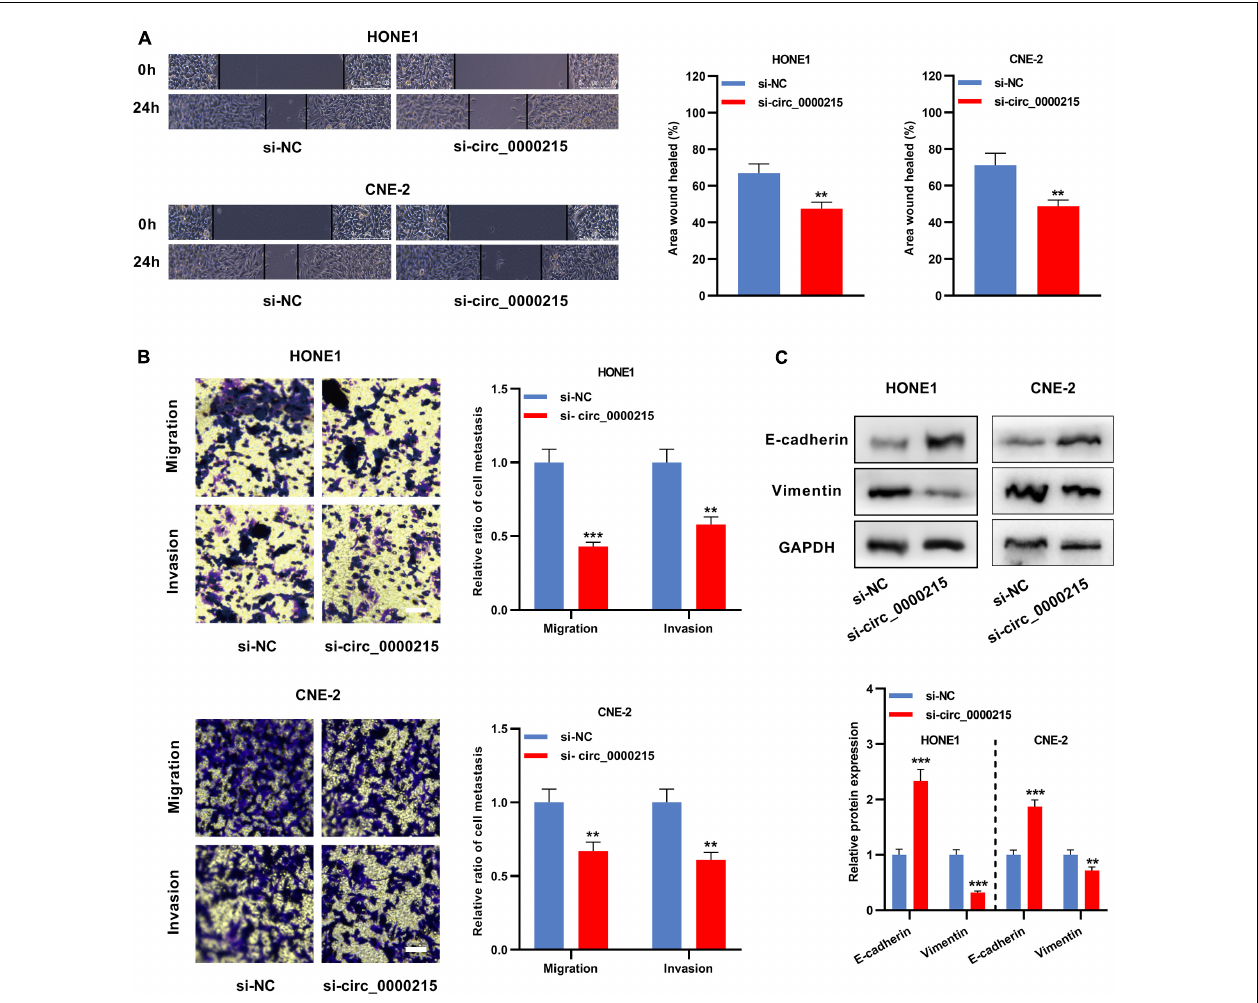
FIGURE 4 | Circ_0000215 inhibition represses the metastatic potential of NPC cells. (A) The wound-healing experiment was carried out to detect the motility of HONE1 and CNE-2 cells transfected with si-circ_0000215. (B) Transwell experiment was executed to detect migration and invasion of HONE1 and CNE-2 cells transfected with si-circ_0000215. Scale bar, 50 µ M. (C) Western blot was used to detect the expression levels of E-cadherin and Vimentin in HONE1 and CNE-2 cells transfected with si-circ_0000215. The significance of difference was determined by Student’s t -test. * P < 0.05, ** P < 0.01, and *** P < 0.001. Data from three independent experiments were expressed as mean ± standard